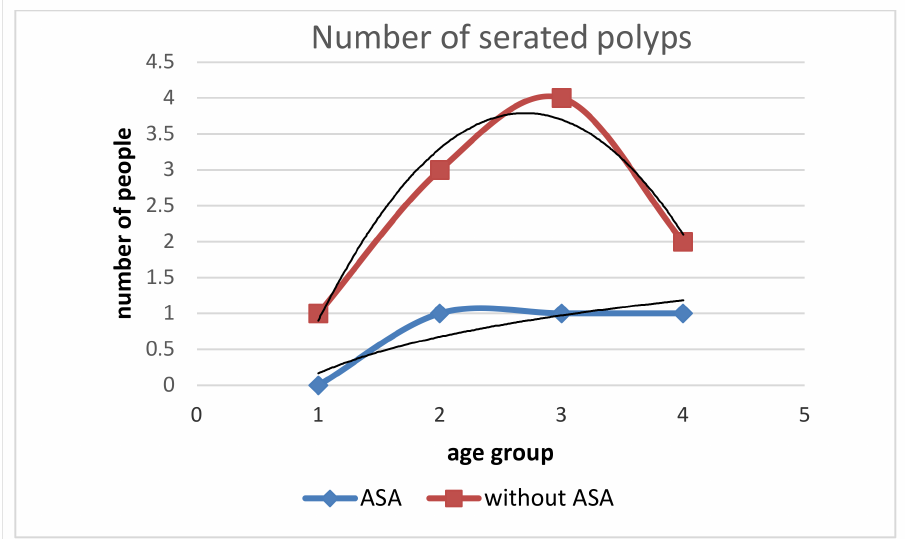
Figure 8. Relationship of serrated polyp incidence in subjects with ASA and without ASA by age groups. In subjects without ASA, the growth rate and total number of serrated polyps decreases with age. There is no increase in the number of serrated polyps in people with ASA between the ages of 50–70